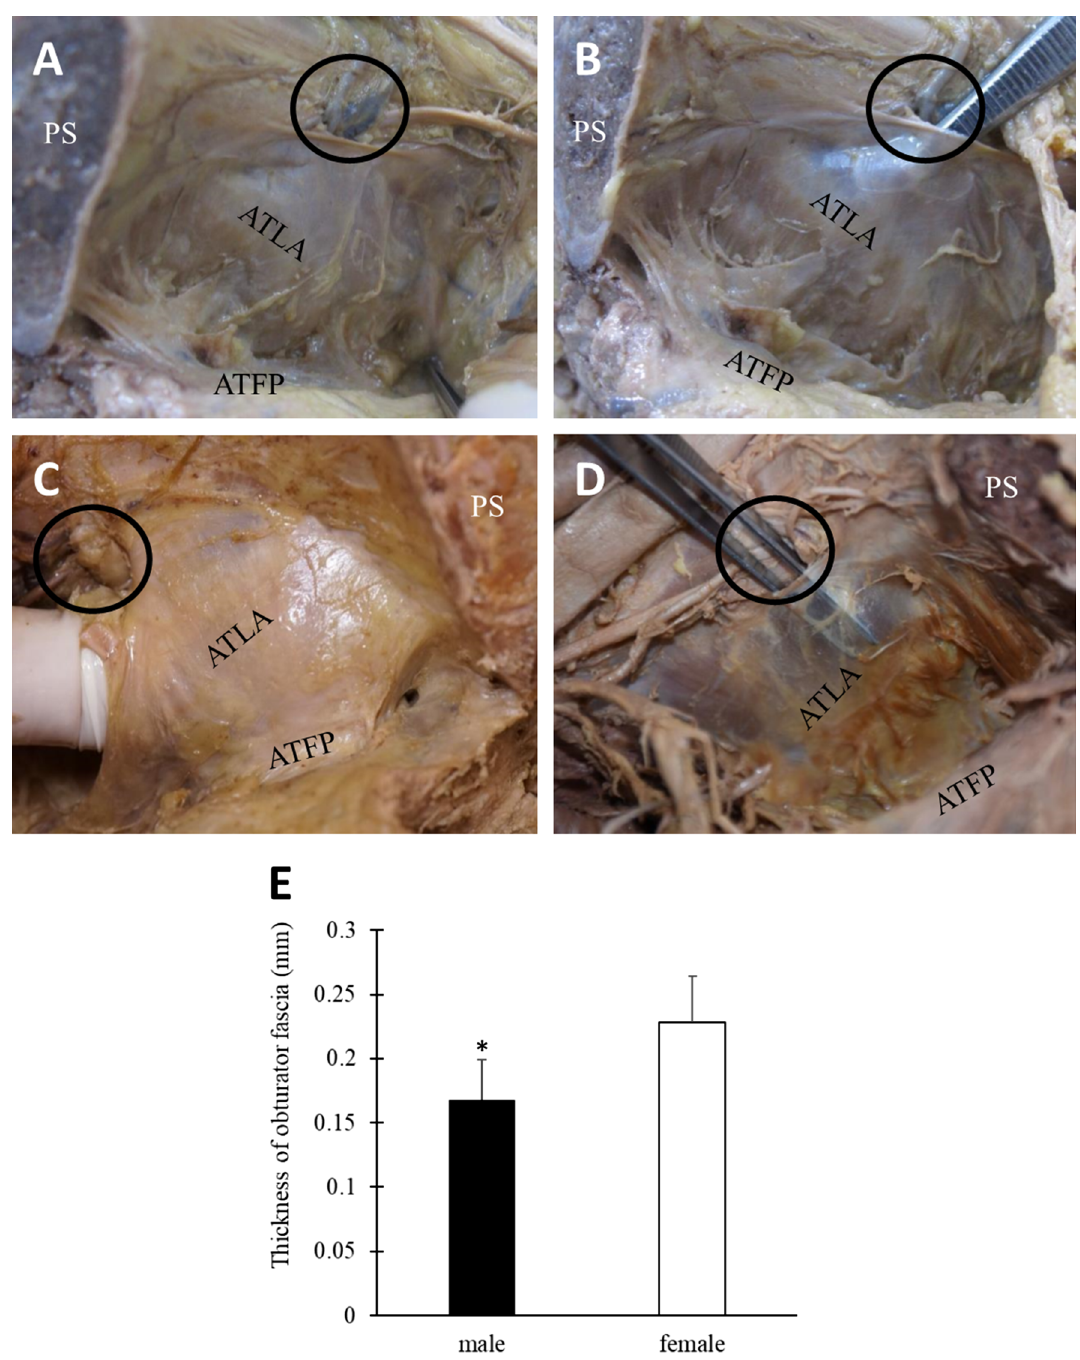
Figure 2. Photographs of the inner side of a hemipelvis with the intact obturator fascia. ( A ) The arcus tendinous levator ani (ATLA) is located within the obturator fascia and attached from the ischial spine to the inferior border of the superior ramus of the pubic bone. The arcus tendineus fasciae pelvis (ATFP) is located between the urinary bladder and obturator fascia and is attached from the ischial spine to the inferior border of the pubic symphysis (PS) in the right pelvis. ( B ) The obturator fascia can be separated from the obturator internus muscle through the obturator canal in the right pelvis. ( C ) The margins of the obturator fascia can also be identified through finger insertion into the space between the obturator fascia and obturator internus muscle in the left pelvis. ( D ) The obturator fascia in the left pelvis of male. ( E ) The thickness of obturator fascia of male is significantly thinner than that of female. The obturator canal is labeled by a circle. * p <